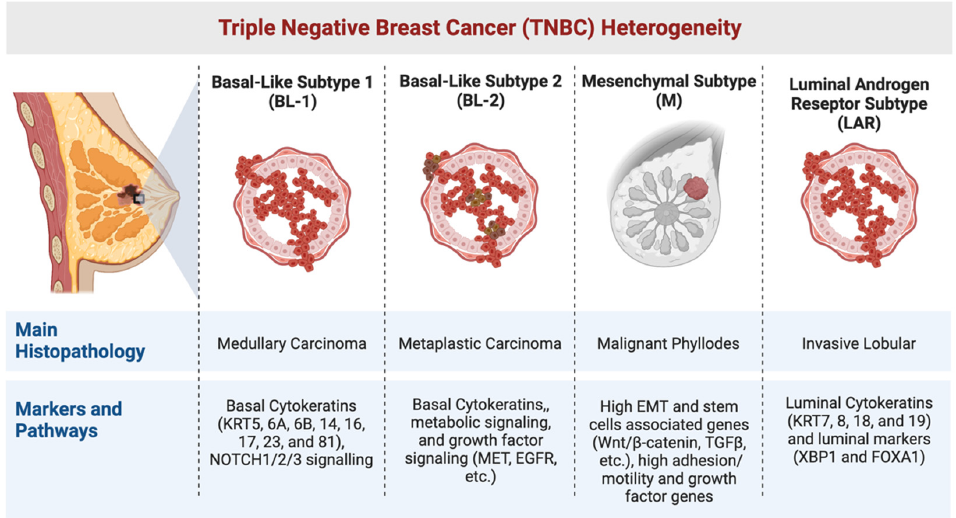
Figure 1. TNBC heterogeneity, showing TNBC subtype's main histopathology, markers, and signalling pathways according to Lehmann et al. 2021 [19]. Created with BioRender.com, agreement number MS248V9M9Z.